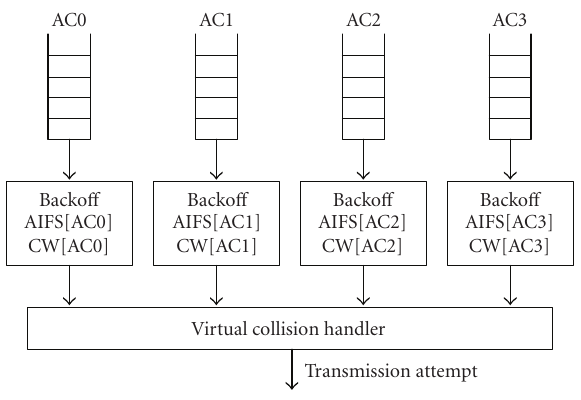
Figure 3: ACs and virtual